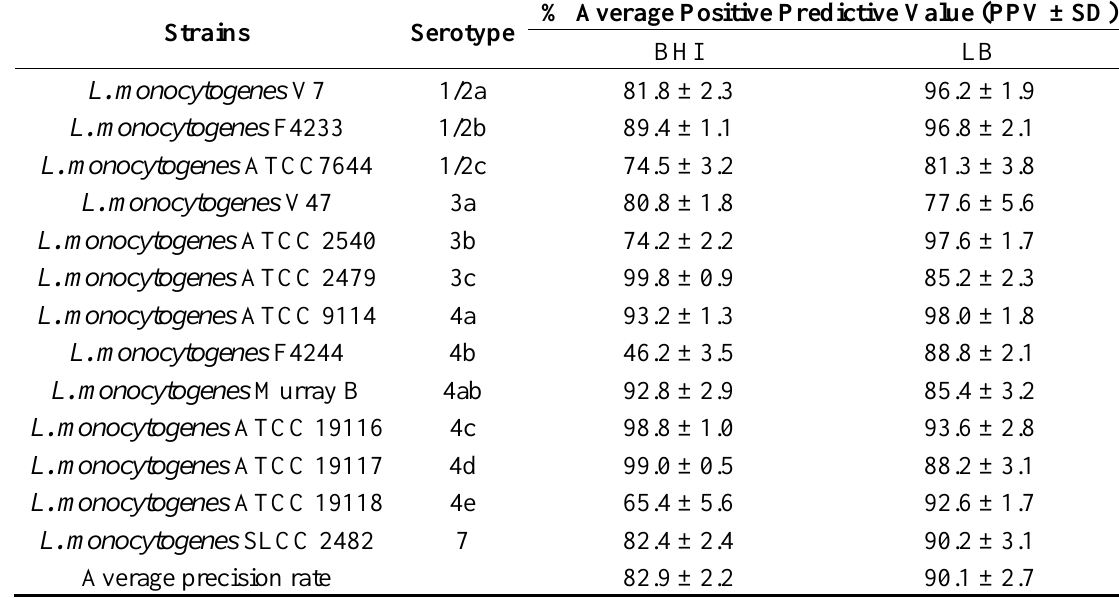
Table 2. Positive predictive value (PPV, precision rate) for the scatter images of colonies obtained from thirteen L. monocytogenes serotypes grown on BHIA and LBA